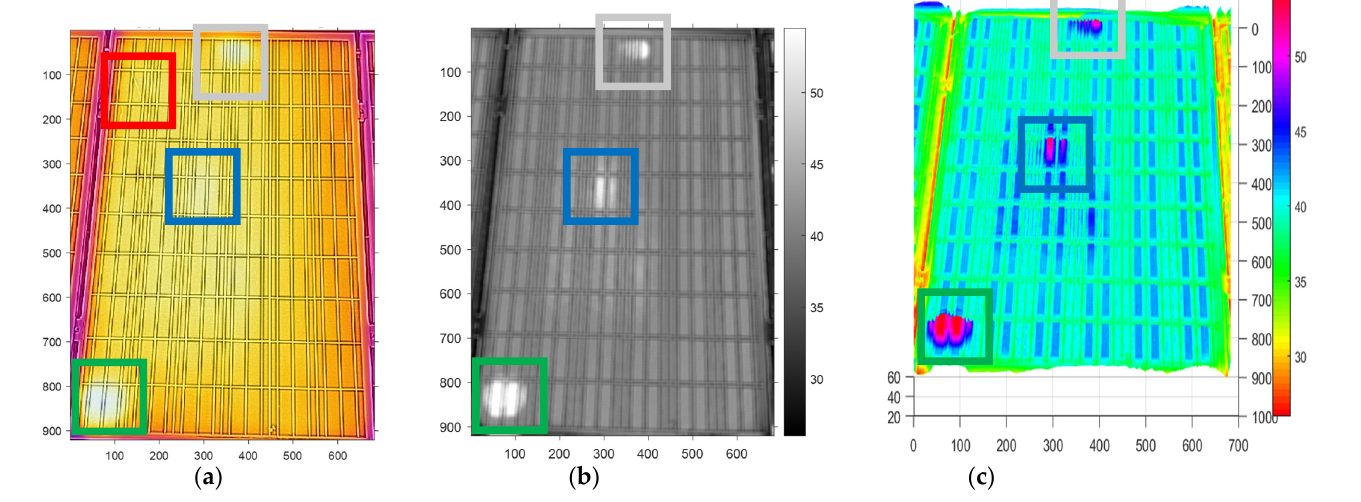
Figure 10. Verification experiment with irradiance at 515 W/m 2 . ( a ) Original IR image. ( b ) Improved box filter after grayscale treatment. ( c ) Improved box filter after 3-D image.